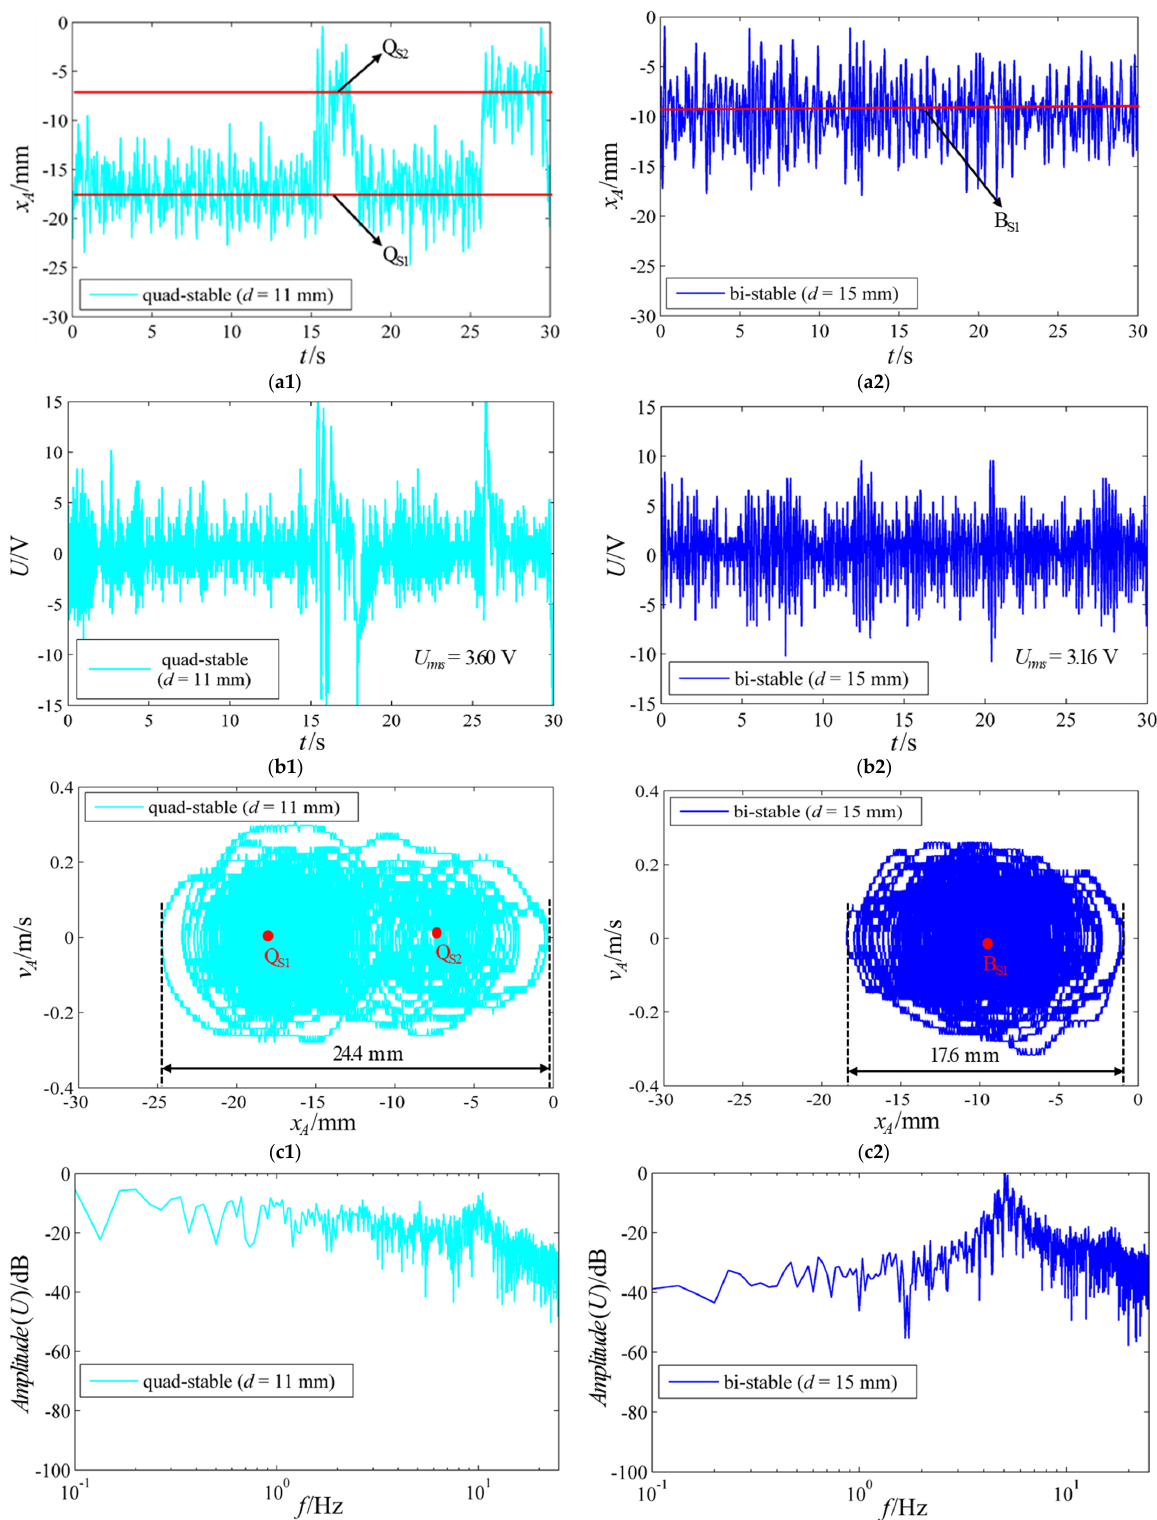
Figure 9. The experimental ( a1 ) output displacement, ( b1 ) open circuit voltage, ( c1 ) phase portrait, and ( d1 ) PSD of the voltage under the quad-stable structural parameters when a Arms = 0.88 g; the ( a2 ) output displacement, ( b2 ) open circuit voltage, ( c2 ) phase portrait, and ( d2 ) PSD of the voltage under the bi-stable structural parameters when a Arms = 0.99